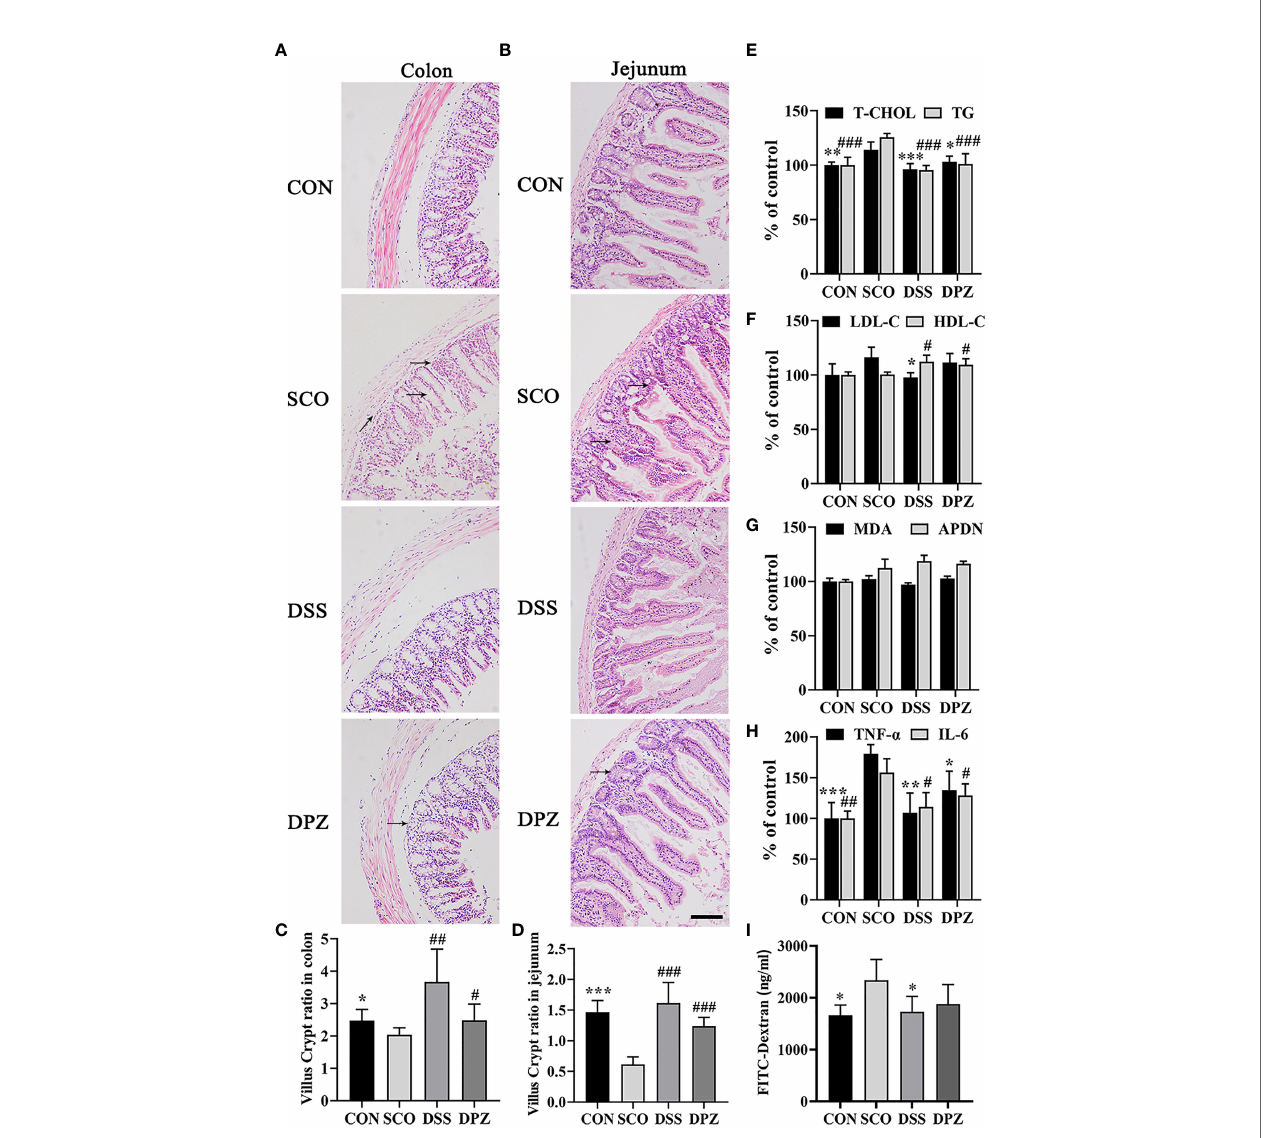
FIGURE 4 | DSS ameliorated intestinal barrier impairment induced by scopolamine. H&E staining was performed to assess the morphology of the jejunum and colon collected from different groups and photographed under a microscope (magni fi cation, ×10), bar = 200 m m. H&E staining images of (A) colon tissues and (B) jejunum tissues. The villus – crypt ratio in the jejunum (C) and colon (D) , * p < 0.05, ** p < 0.01, *** p < 0.001 vs. CON, # p < 0.05, ## p < 0.01, ### p < 0.01 vs. SCO. (E – I) In fl ammation cytokines and lipid levels in serum (n=3-5). (E) Total cholesterol (T-CHO) expression in the serum of the mice * p < 0.05, ** p < 0.01, *** p < 0.001 vs. SCO; total glyceride (TG) expression in the serum of the mice ### p < 0.001 vs. SCO, and expression in the serum of the mice. (F) Low-density lipoprotein cholesterol (LDL-C) expression in the serum of the mice * p 0.05 vs. SCO; high-density lipoprotein cholesterol (HDL-C) expression in the serum of the mice # p < 0.05 vs. SCO. (G) Adiponectin (APDN) and malondialdehyde (MDA) expression in the serum of the mice. (H) TNF- a expression in the serum of the mice. (I) FITC-dextran in the serum of the mice caused by scopolamine * p < 0.05, ** p < 0.01, *** p < 0.001 vs. SCO; IL-6 expression in the serum of the mice # p < 0.05, ## p < 0.01 vs.